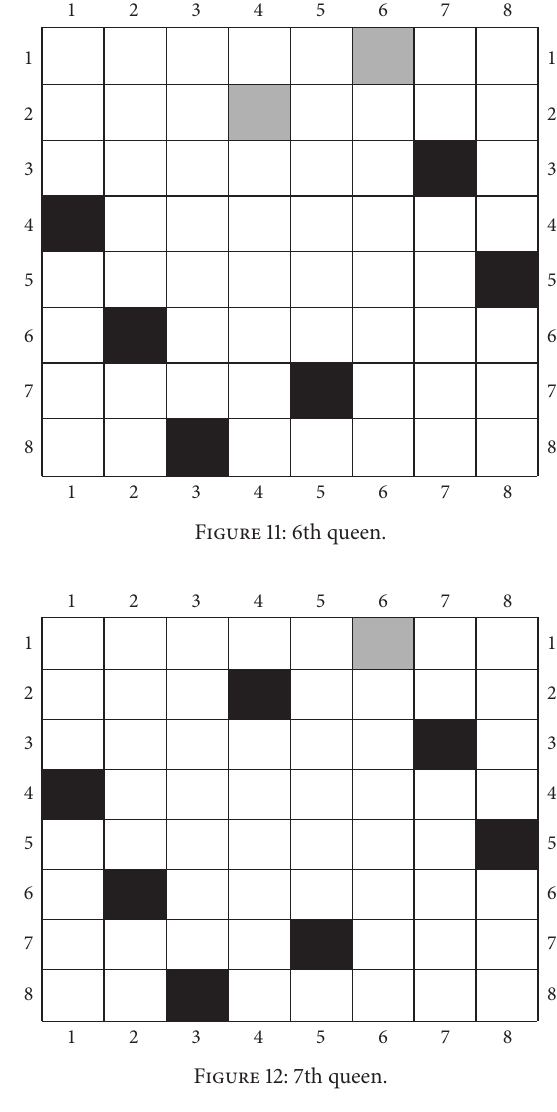
Figure 9: 4th queen.